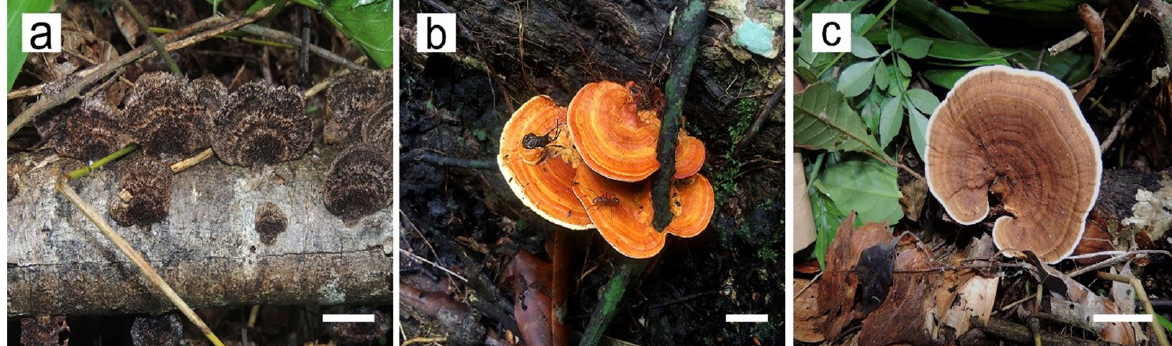
Figure 2. Basidiome of the most abundant macrofungal species in the occurring near the Silvio Braga HPP, Santarém, PA. a) Cerrena hydnoides , b) Rigidoporus lineatu s and c) Trametes